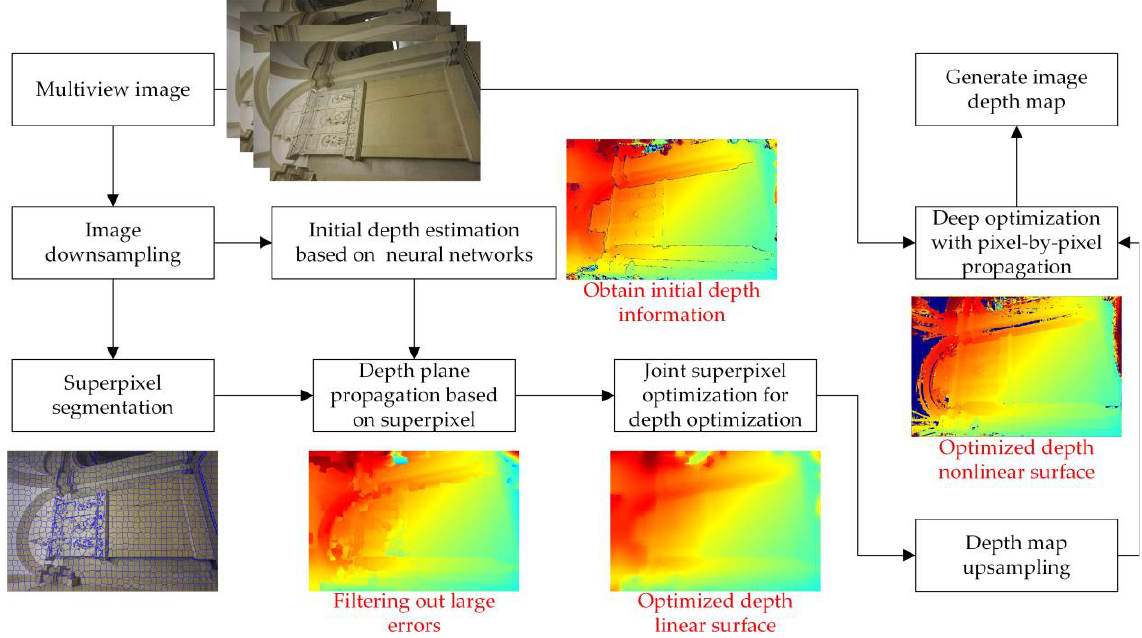
Figure 2. Multiview image depth estimation method.